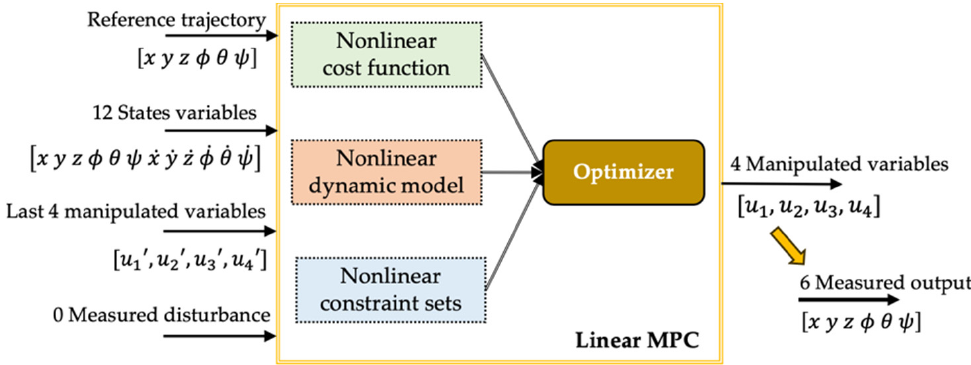
Figure 8. Nonlinear MPC controller inputs and outputs.